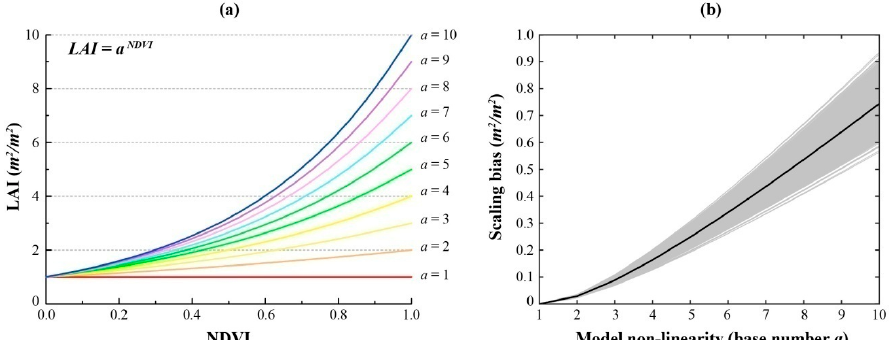
Figure 5. The relationship of model non-linearity with scaling bias. ( a ) The non-linearity of LAI estimation model ( LAI = a NDVI ) represented by the base number a . ( b ) The relationship between base number a and the scaling bias. The grey lines represent the simulations of 10,000 groups and the black line represent the average scaling bias.